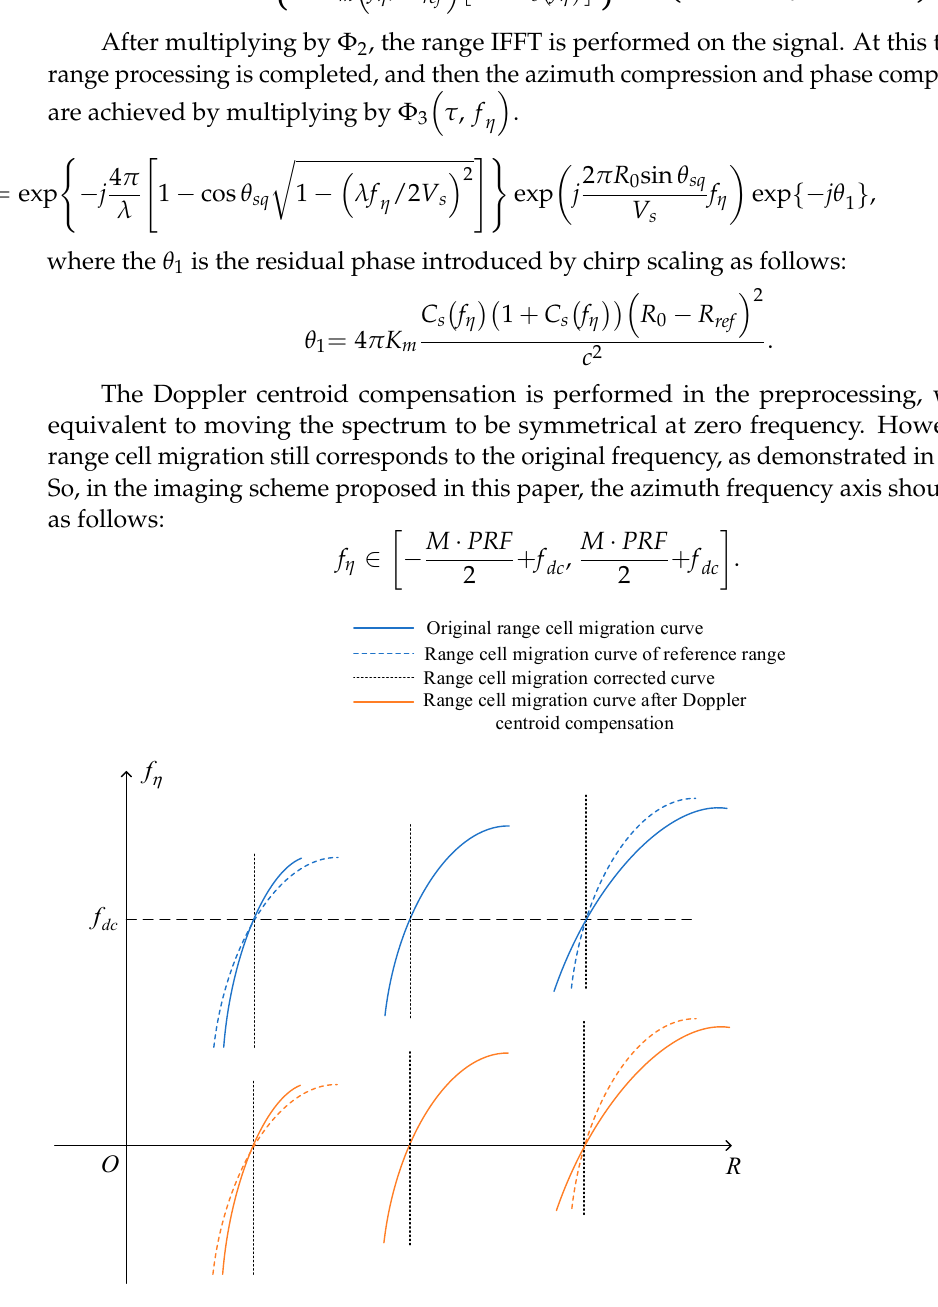
Figure 5. The diagram of range cell migration before and after Doppler centroid compensation.